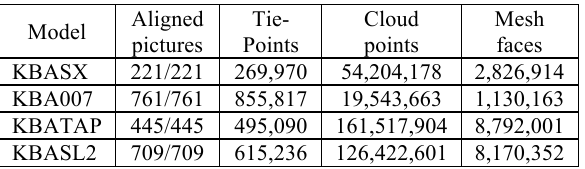
Table 3 . Metrics for four models generated from images acquired with the new compact setup